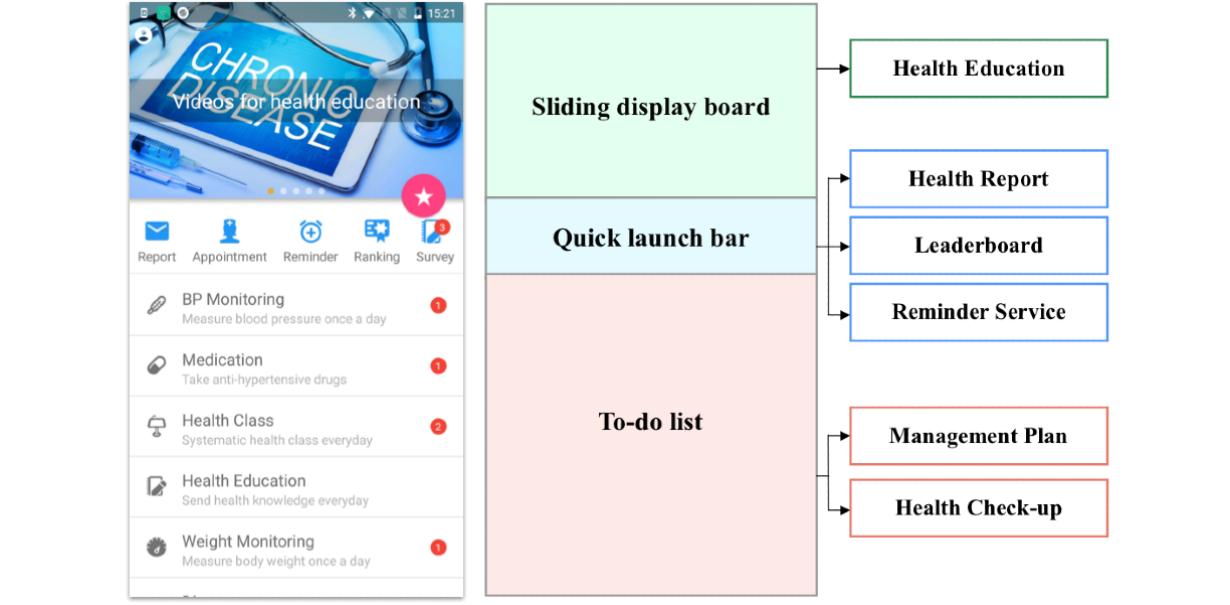
Figure 9. Main Blood Pressure Assistant